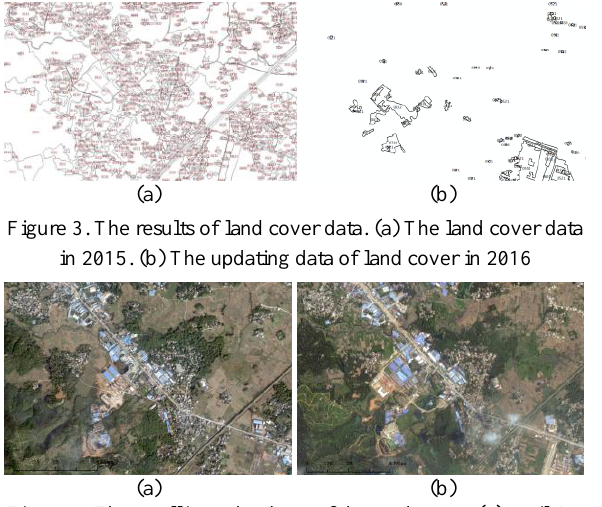
Figure 4. The satellite orthophoto of the study area. (a)April 21,